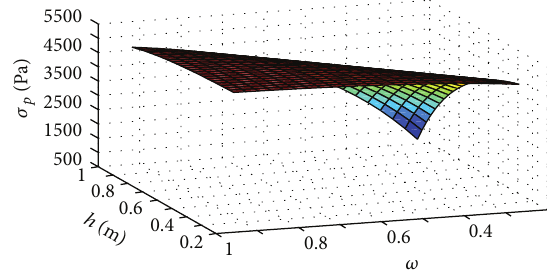
Figure 6: Variation of 𝜎 𝑝 with ℎ and 𝜔 .